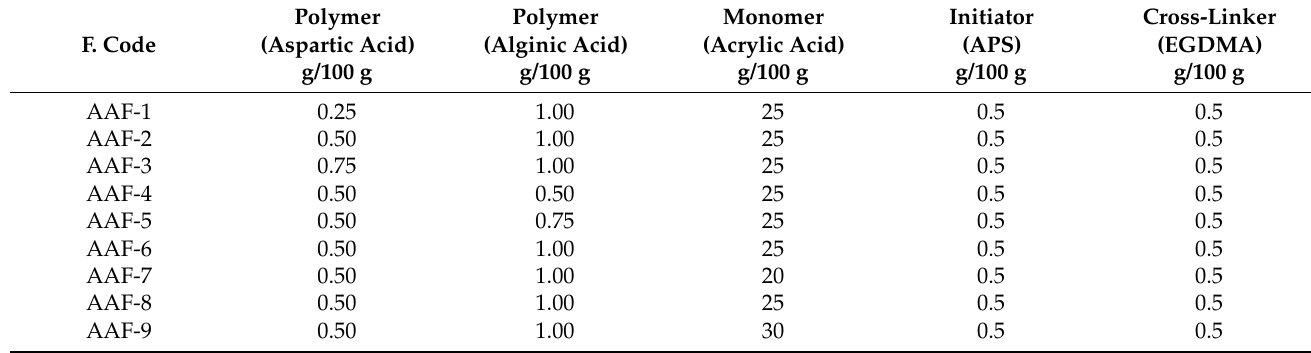
Table 3. Feed ratio scheme for formulation of APS/ALPAA